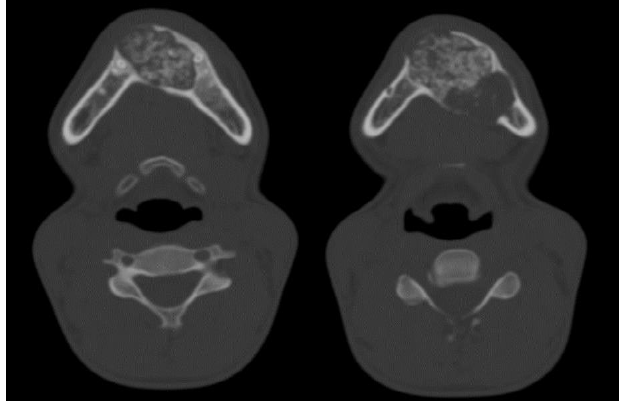
Fig. 2. Axial view of a computed tomography scan showing a unilocular isodense mass delimited by a hyperdense border with multiple hyperdense particles